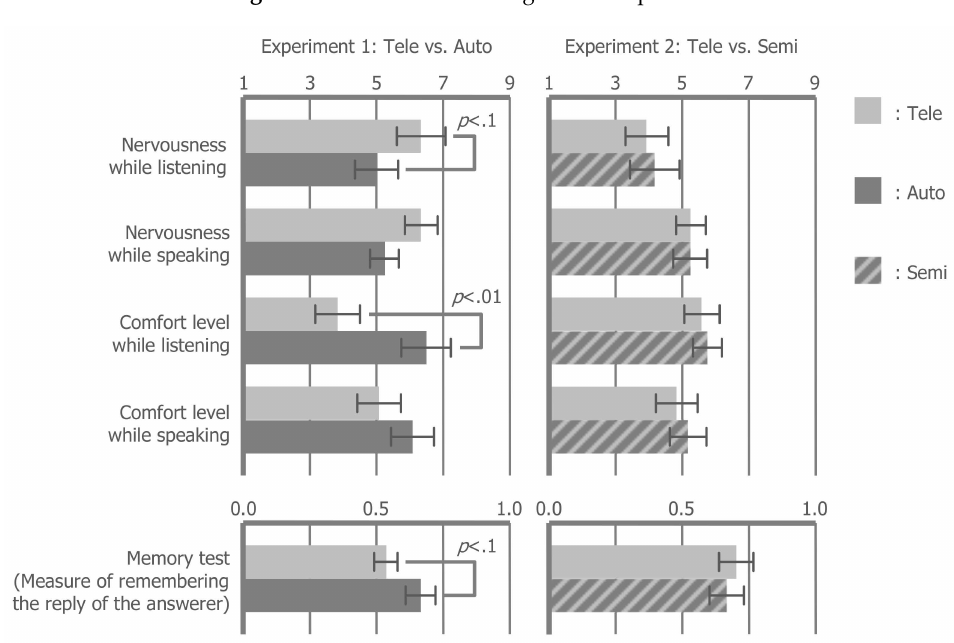
Figure 5. Results of measuring social telepresence.